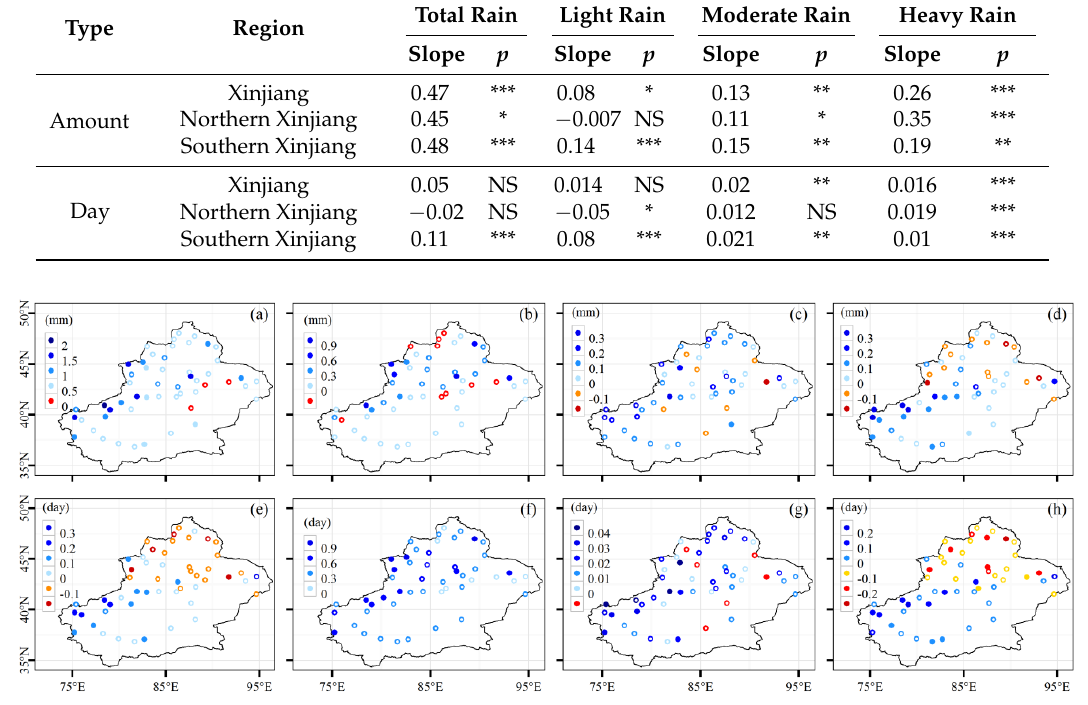
Figure 2. Spatial trends for rain amounts (mm/year) and days (day/year) for total rain and for the three rain classes (light, moderate, and heavy rain) in Xinjiang during the warm season (May to October) from 1960–2014. Total rain amounts; ( b ) light rain amounts; ( c ) moderate rain amounts; ( d ) heavy rain days; ( e ) total rain days; ( f ) light rain days; ( g ) moderate rain days; and ( h ) heavy rain days. Solid dots at stations indicate significance at the 0.05 level.